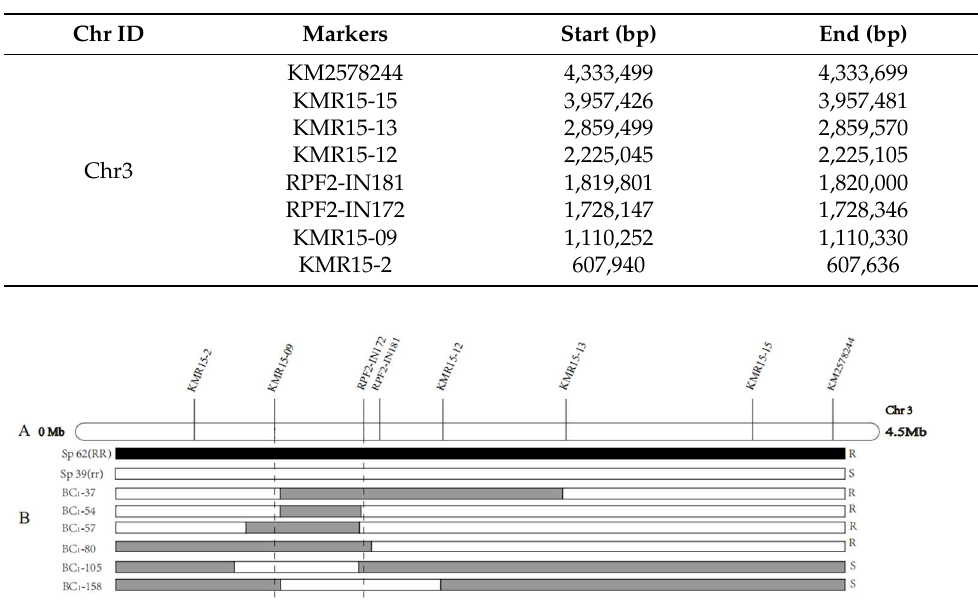
Figure 1. Mapping analysis of RPF2 ( A ) Fine mapping analysis delimited RPF2 to a 0.61 Mb interval flanked by the SNP markers KMR15-09 and RPF2-IN172. ( B ) Six recombinants are shown. The black segments represent the resistant Sp62 genotype, and the white segments indicate the susceptible Sp39 genotype.